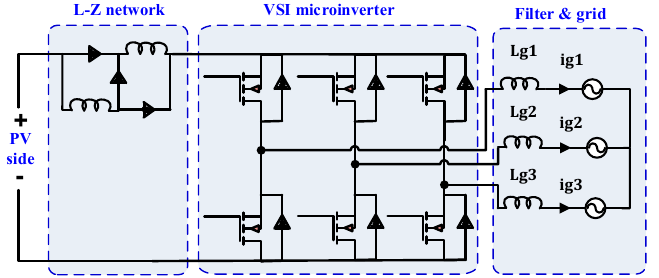
Figure 13. Modified ZSI (L-ZSI) structure [101].